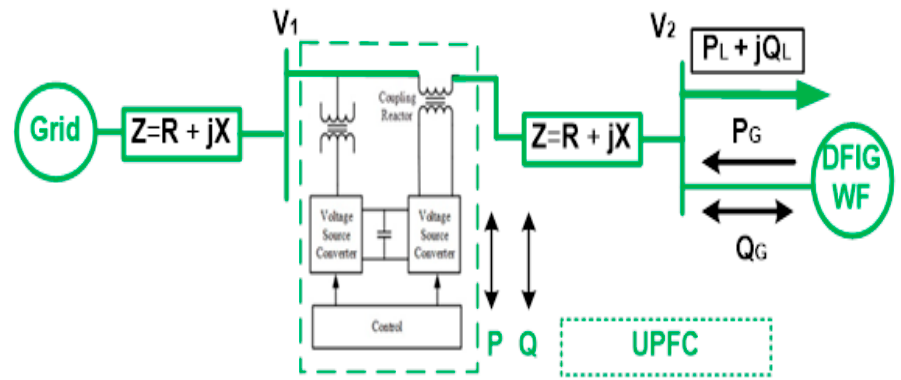
36 of 38 Figure A3. Schematic/connection diagram of SSSC in test system. Appendix B.5. Unified Power Flow Controller (UPFC) The UPFC is a FACTS device used to control and manage power flows in a power system using power electronics. The connection/schematic of UPFC is shown in Figure A4 and controls both P and Q flows [7]. UPFC is a hybrid device comprised of shunt and series controllers coupled through a